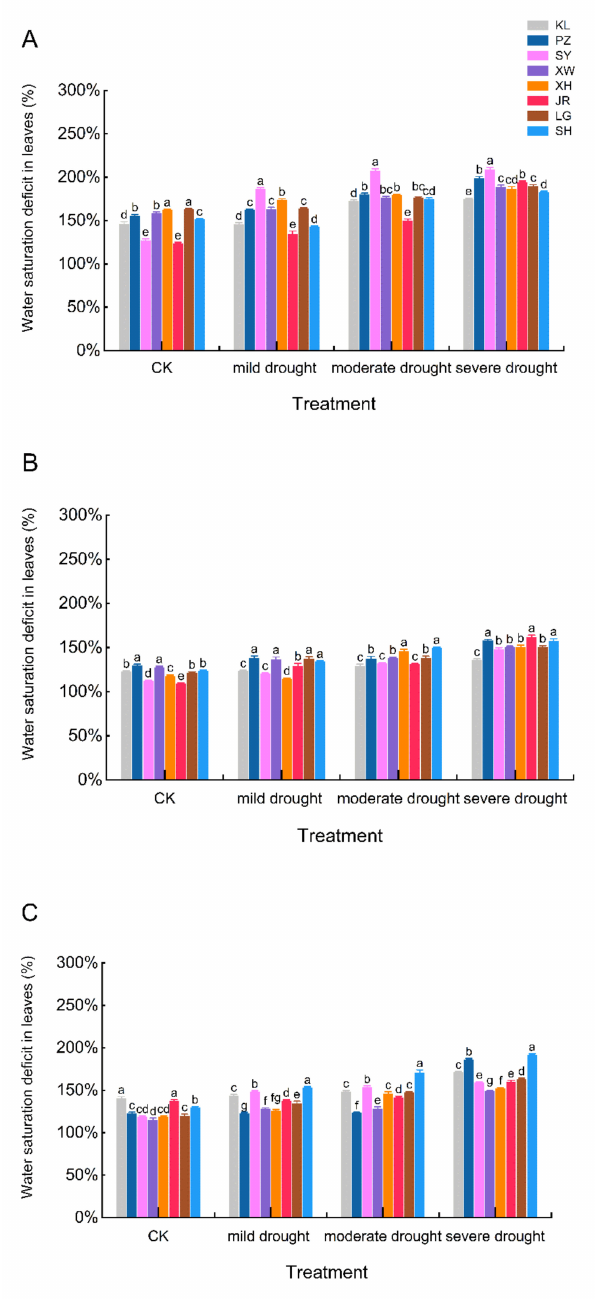
Figure 2. The water saturation deficit in the leaves of Melia azedarach among different provenances: ( A ): early stage, ( B ): middle stage, and ( C ): late stage. Note: The error line in the figure is the mean ± standard error, and different lowercase letters in the same treatment indicate significant differences at the 0.05